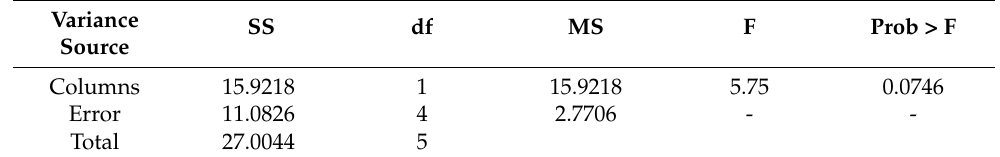
Table 5. ANOVA test on statistical PSD data based on the selected classifiers.